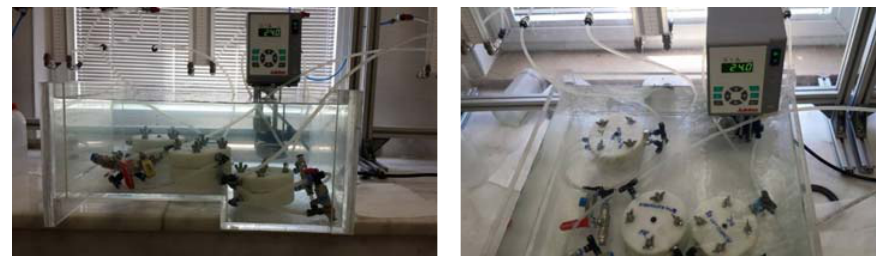
Figure 3: Hydraulic conductivity test arrangement.